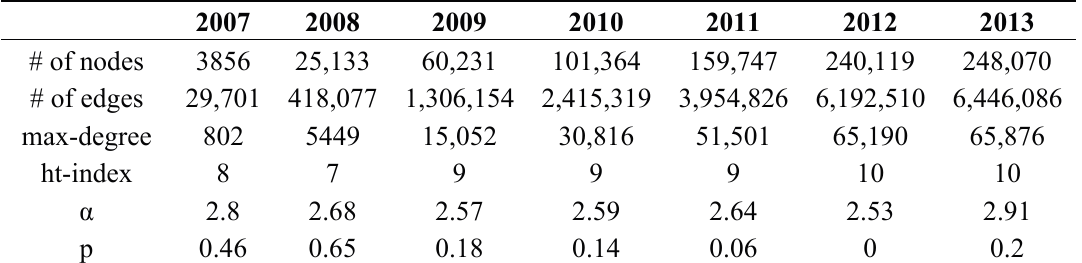
Figure 6. The co-contribution network for the top five hierarchical levels involving 477 nodes and 80,957 edges. The scaling hierarchy of far more small nodes than larger ones is indicated by the size of red dots. Table 5. Scaling analysis results of co-contribution networks from 2007 to